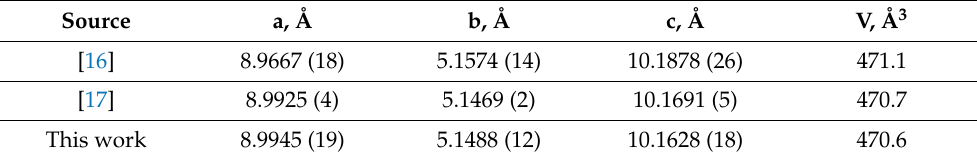
Table 1. Lattice parameters of Li 2 Ni 2 TeO 6 ( Cmca ) from different